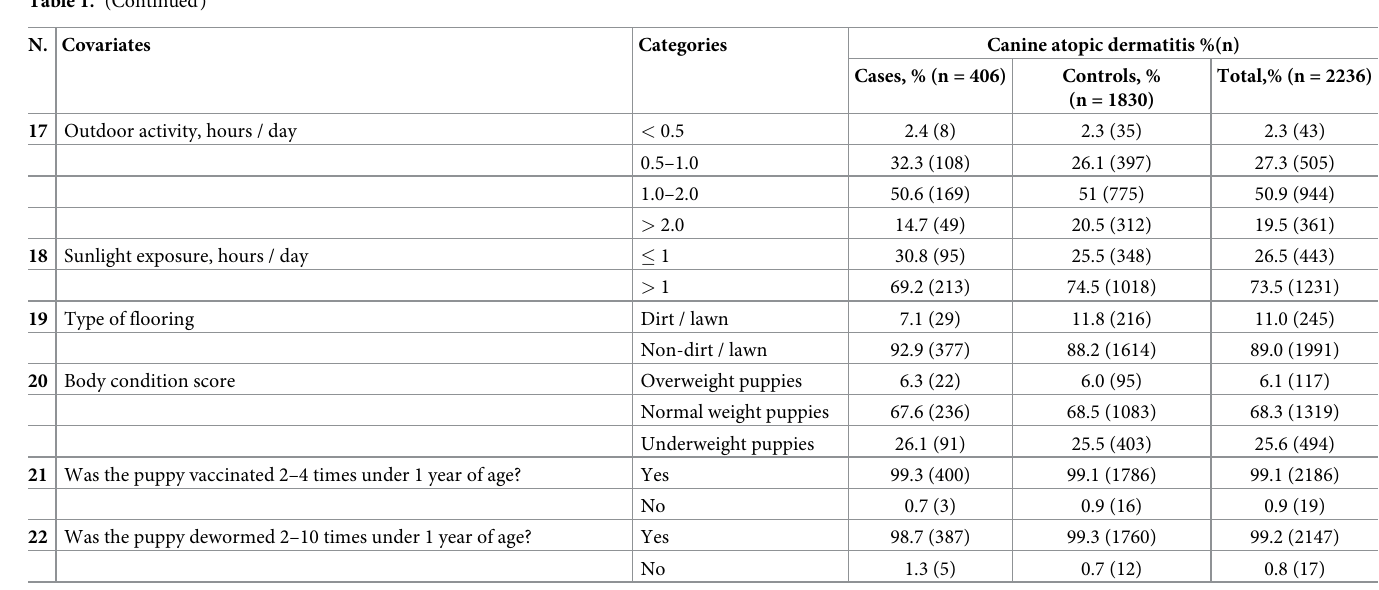
skin symptoms (n = 406) while the allowed controls had to report that they neither had CAD nor skin symptoms (n = 1830) giving us a final adult dog population for analysis of n = 2236. This study was carried out to test the association between CAD and different nutritional, envi- ronmental, genetic and demographic variables in the pre- and postnatal periods (Fig 1).